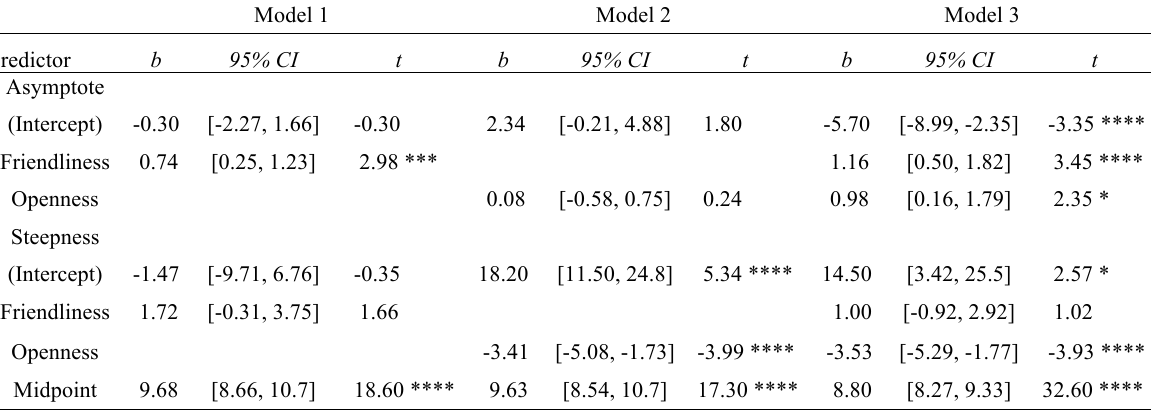
Table 5 Details of Non-Linear Regression Models of Interest, Predicting Progress